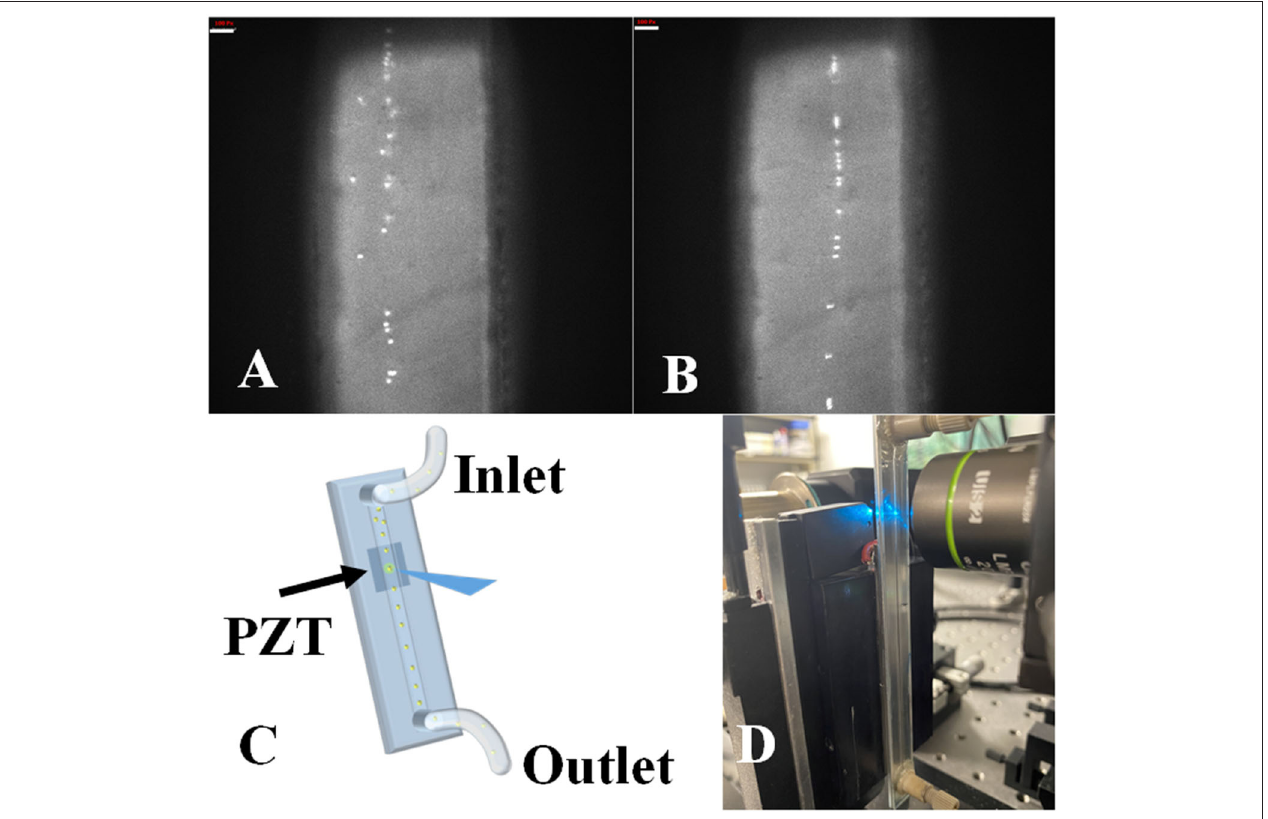
FIGURE 3 | Dot plot, intensity, and lifetime histogram data for fluorospheres and MCF-7 cells. (A) A polygon gate was applied to the entire dot plot population for YG fluorospheres. The mean intensity was recorded at 12730A.U. with a CV of 33.43%. The corrected mean lifetime was recorded as 5.07 ± 1.66 ns from DAQ acquisition. (B) The same method was applied for FlowCheck ® fluorospheres with respect to the dot plot gating. Mean intensity value was measured at 18394A.U. with a CV of 13.29%. The mean corrected lifetime was measured at 5.07 ± 1.66 ns with visible bi-modal populations. (C) Propidium-labeled MCF-7 cells were acquired for up to 1,000 events. Mean fluorescence intensity was measured at 21958A.U. with a CV of 5.56%. Mean corrected lifetime was measured at 5.73 ± 0.76ns. (D) The acoustofluidic device used in the modular TRAFFC system.